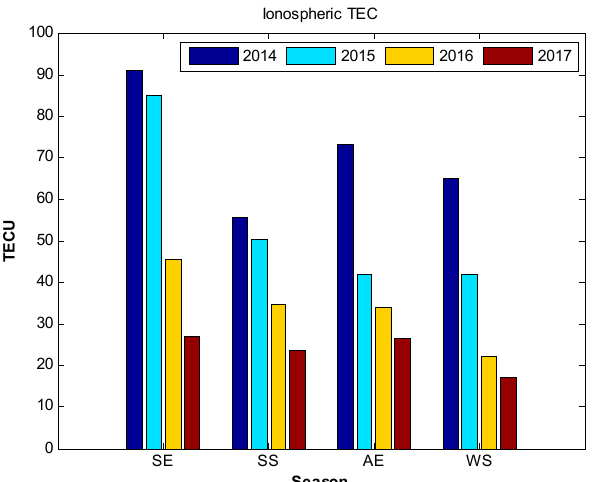
Figure 6. The average ionospheric TEC at 18:00 local time (LT) for different seasons during each year from 2014 to 2017. SE, SS, AE, and WS represent the spring equinox, summer solstice, autumn equinox, and winter solstice, respectively.